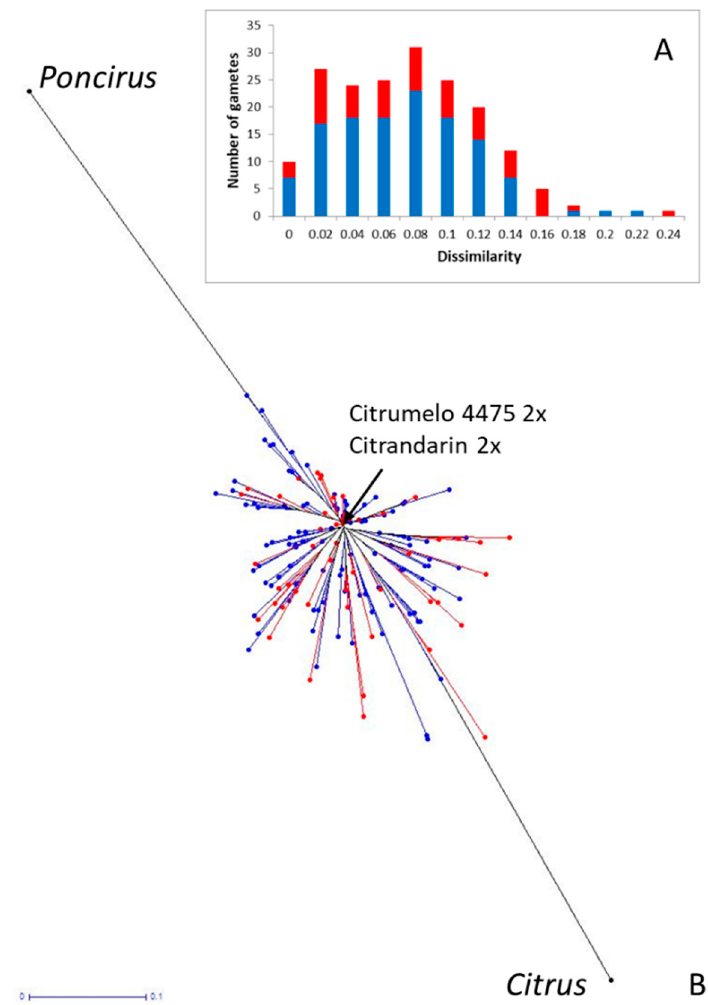
Figure 8. Genetic diversity of diploid gametes of Citrumelo 4475 (blue) and Citrandarin (red). ( A ) histogram of dissimilarity with the diploid intergeneric parent. ( B ) NJ tree of the gamete population, ancestor genera and intergeneric parents.